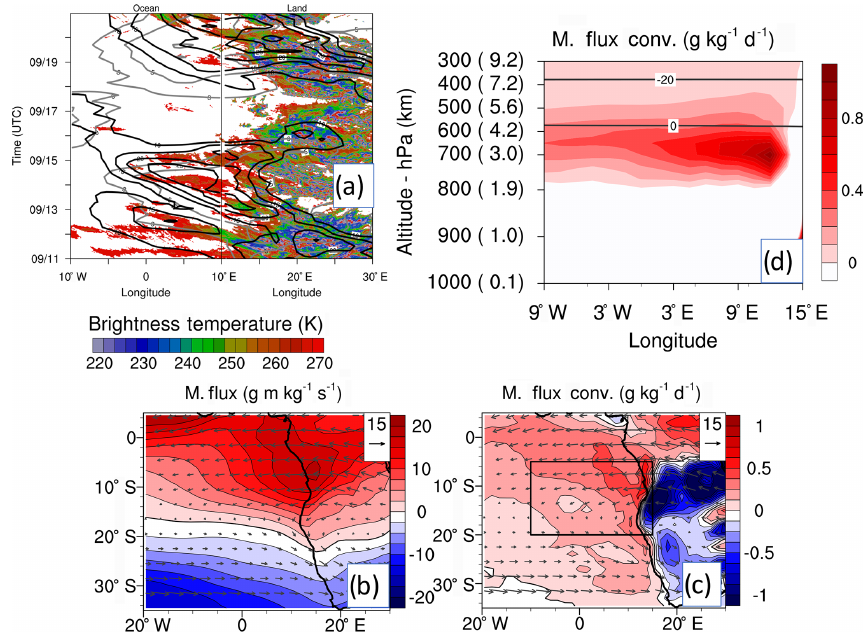
Figure 7. (a) An example showing the longitude–time cross section of brightness temperature (K; shaded), easterly zonal wind speed (gray contours between 3 and 15ms − 1 at 2ms − 1 interval), and moisture flux (black contours between 10 and 30gmkg − 1 s − 1 at 5gmkg − 1 s − 1 interval) between 3 and 8km and latitude range of 5–20 ◦ S for 11–20 September 2016. The July–October (2006–2010) ERA-Interim (b) moisture flux (gmkg − 1 s − 1 ) and (c) moisture flux convergence (gkg − 1 d − 1 ) , averaged between 3 and 8km. Positive is convergence, and negative is divergence. The arrows are the moisture flux vectors referenced at 15gmkg − 1 s − 1 . (d) The longitude–height transect of the moisture flux convergence averaged between 5 and 20 ◦ S (black box in c ). The horizontal lines in (d) represent the 0 ◦ C and − 20 ◦ C isotherms averaged over the same